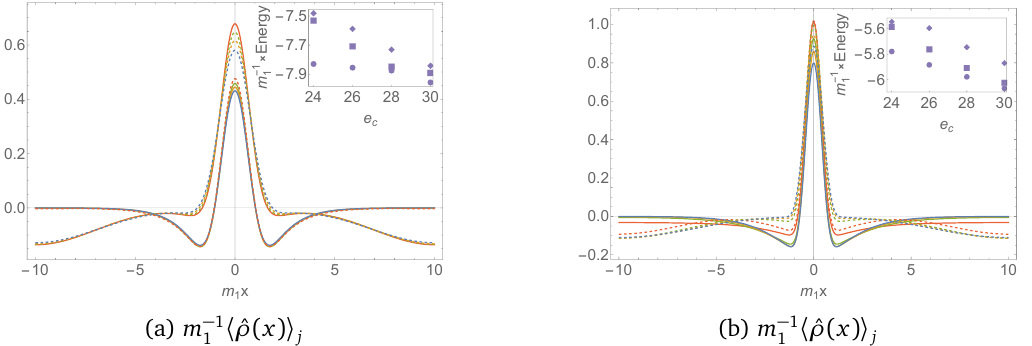
Figure B.1: Eigenstate crossing (a) and hybridisation (b) in the inhomogeneous quantum sine–Gordon problem w.r.t. changing the truncation cut-off. The figures display the QFT expectation value of the topological charge density 〈 ˆ ρ ( x ) 〉 in the j ground state (continuous lines) and the first excited state (dashed lines). The para- / 2, A β / m = 18, m σ = 2 / 3 and L = 20 and (a) β = β meters are m , (cid:96) = m 1 1 FF FF 1 1 / 1.5, A β / m = 12, m σ = 1 / 3. The blue, orange green and red curves (b) β = β FF FF 1 1 correspond to cut-offs 24, 26, 28 and 30. The insets display the energies of the first three